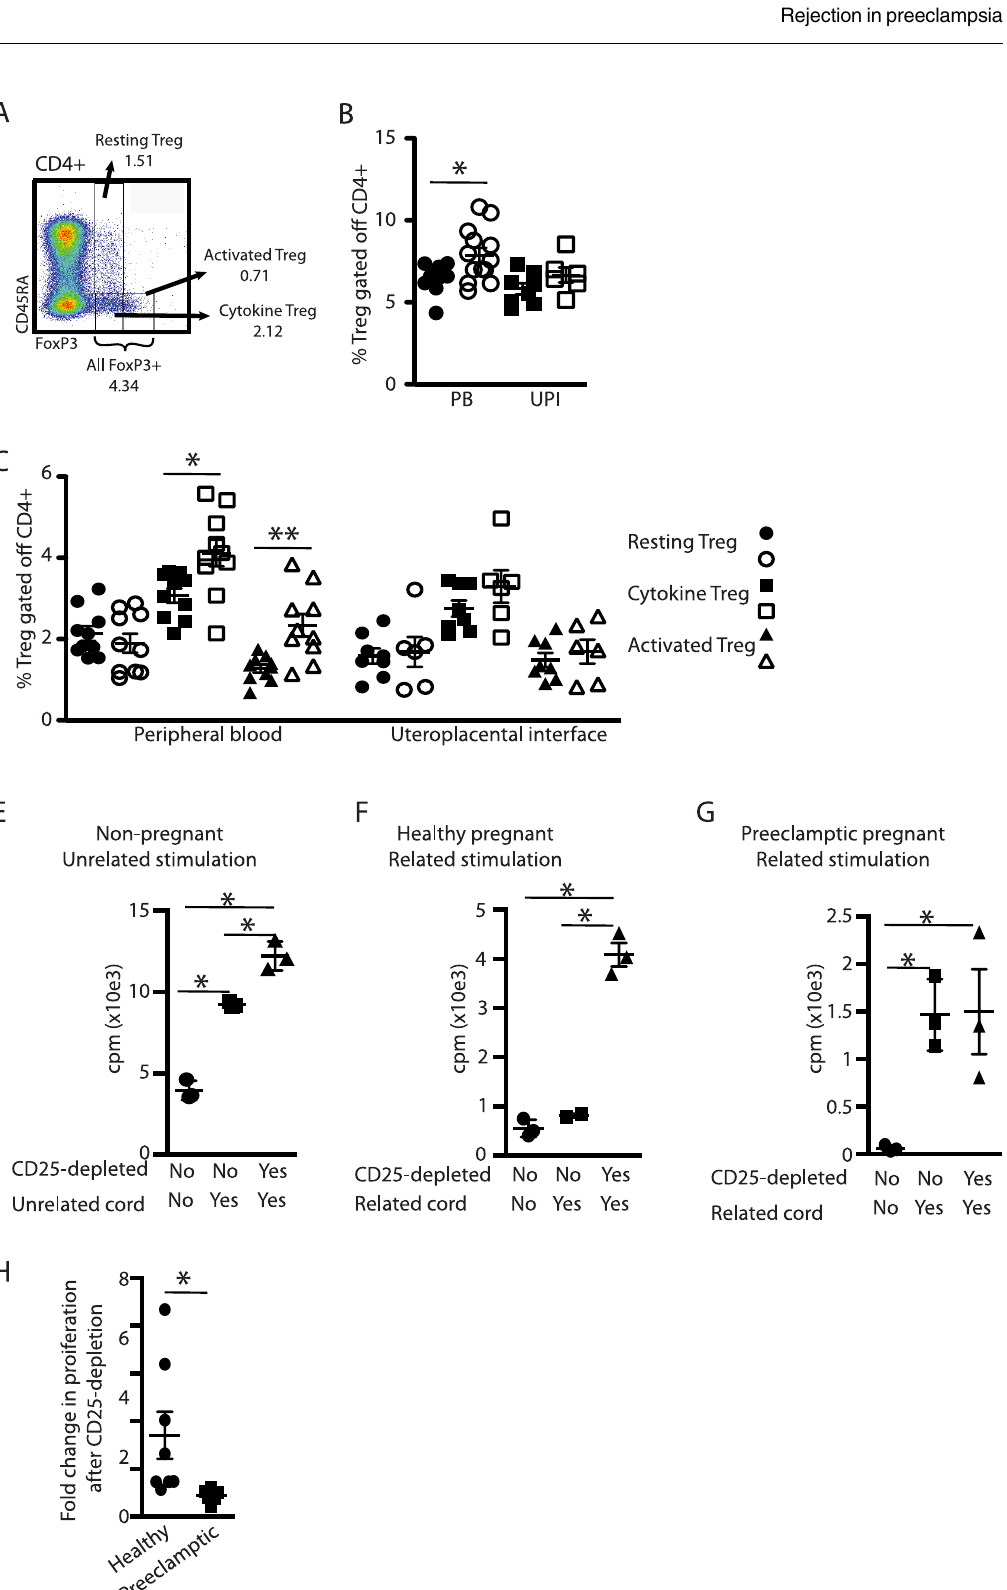
PLOS ONE | https://doi.org/10.1371/journal.pone.0188250 November27,